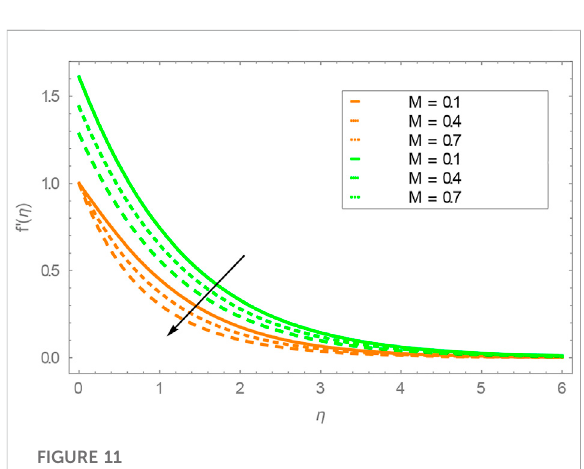
FIGURE 11 Inspiration of shrinking and stretching parameters λ on the velocity pro fi